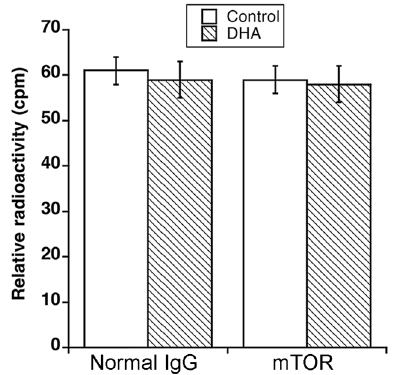
Figure 3. DHA does not directly bind to mTOR or FKBP12. Rh30 cells were pretreated with in vivo labeled with 10 μ Ci [ 3 H]-DHA for 21 h. The cell lysates were used for immunoprecipitation with anti-mTOR antibodies or normal IgG (control). Shown is the relative radioactivity (cpm) of immunoprecipitation products.